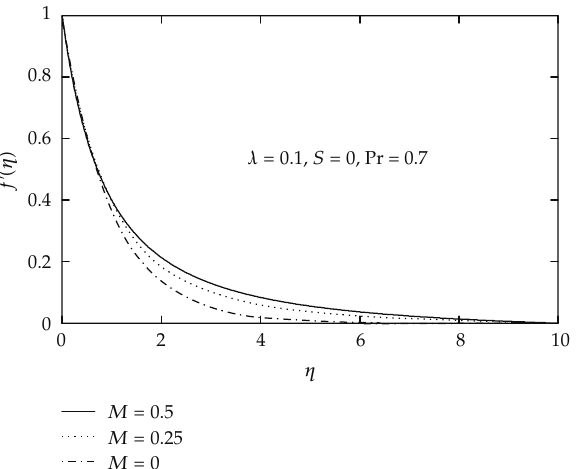
Figure 1: Variation of velocity f (cid:4) (cid:6) η (cid:7) with η for several values of the curvature parameter M when λ (cid:9) 0 . 1, S (cid:9) 0, and Pr (cid:9) 0.7.